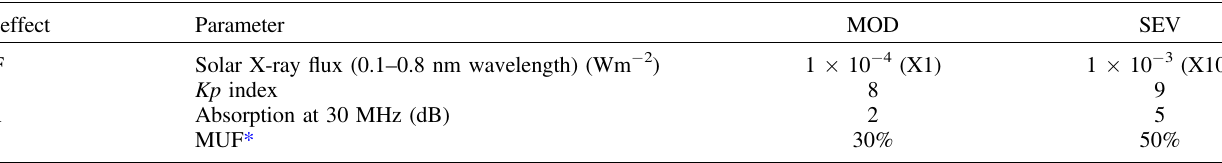
Table 1. Parameters and activity levels describing MOD and SEV level activity for shortwave fadeout (SWF), auroral absorption (AA), polar cap absorption (PCA), and post-storm maximum usable frequency depression (PSD) based on ICAO regulations (ICAO,